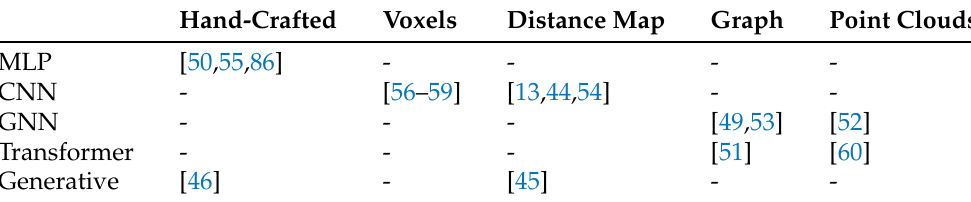
Table 2. Explicit representations of the structure and the neural architecture they are fed into. Hand-Crafted Voxels Distance Map Graph Point Clouds MLP [50,55,86]